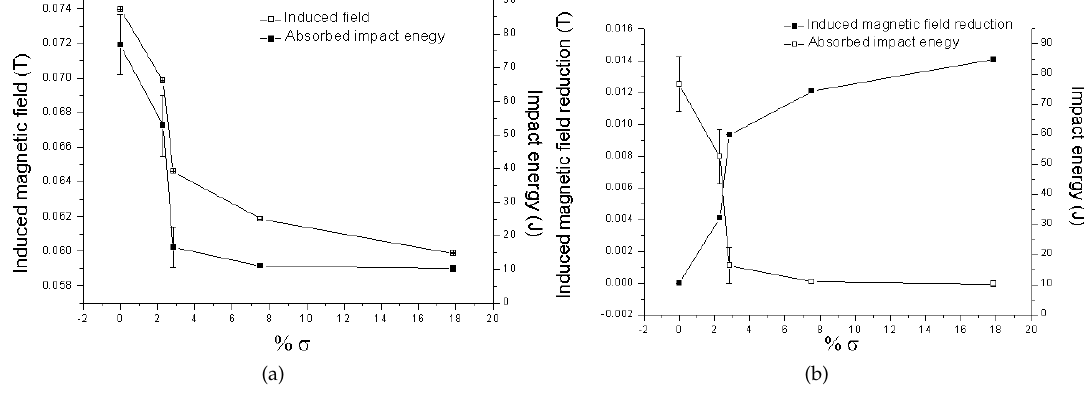
Figure 2. ( a ) Induced magnetic field and absorbed energy in terms of sigma phase percentage; ( b ) induced magnetic field reduction due to sigma phase in function of absorbed